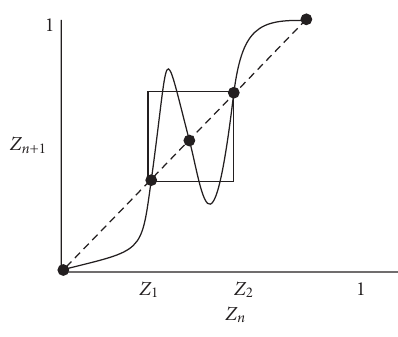
Figure 3.3. Example of a function in which the interval [ Z 1 , Z 2 ] maps outside of itself but within